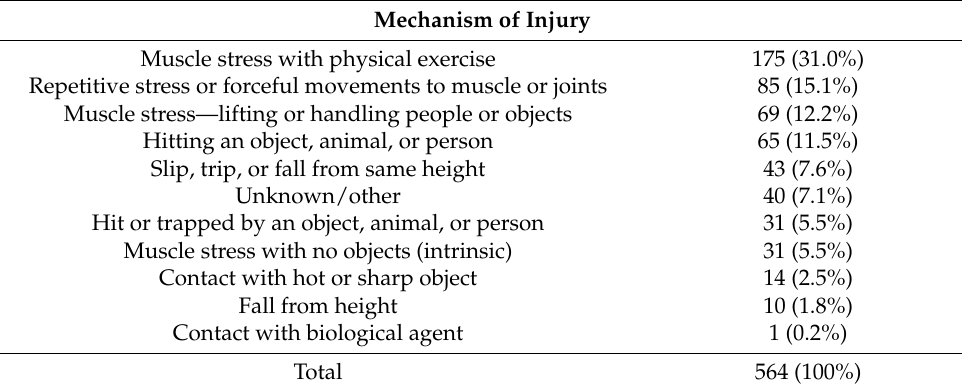
Table 5. Mechanism of injury in the NZ Police Force. Reported as number of injuries (percentage).